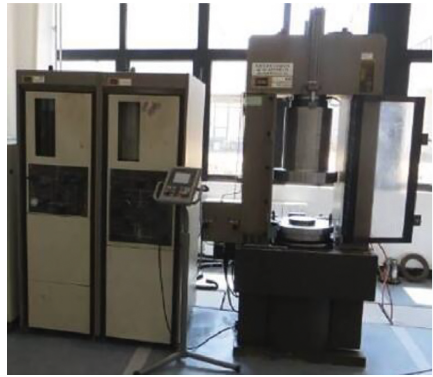
Figure 4: (a) Grouting reinforced body (270 mm (50mm 100mm) cored from the grouting reinforced body. ×